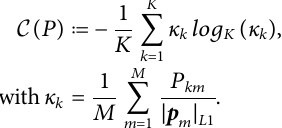
Frontiers in Robotics and AI |